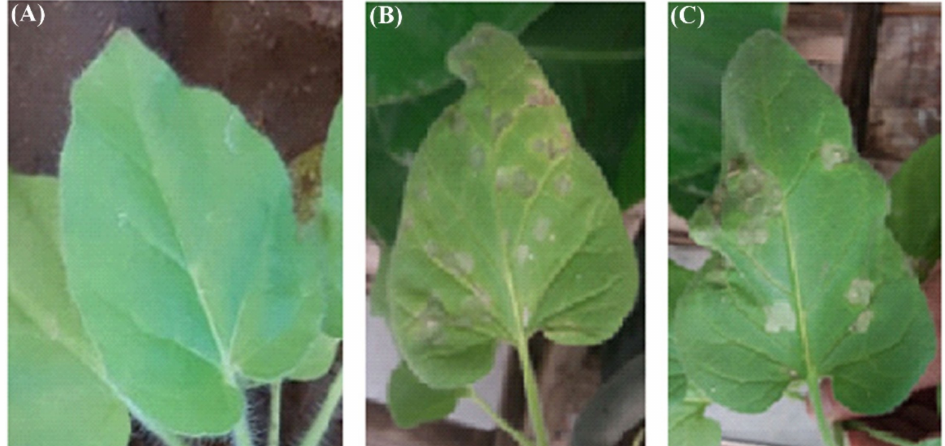
Figure 3. Nicotiana glutinosa mechanically inoculated with the two mixtures ( Tomato mosaic virus particles treated with 50 mg/L of ZnO-NPs ( B ) and 100 mg/L of ZnO-NPs ( C ) in vitro for 2 h compared to healthy ( A ).